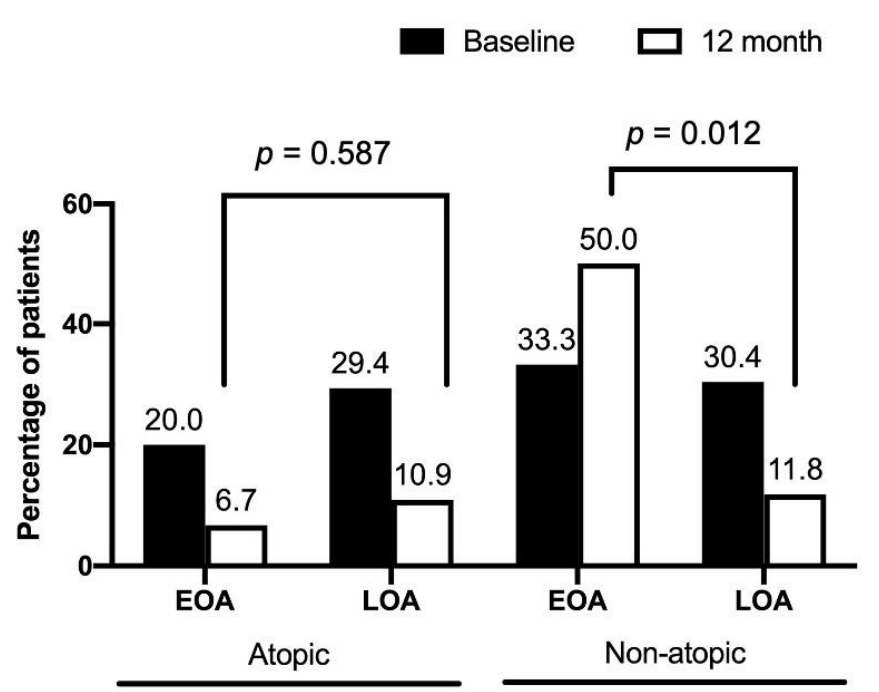
Figure 4. Percentage of acute exacerbations in early-onset asthma (EOA) and late-onset asthma (LOA) patients with atopic and nonatopic status after 12-month treatment. The baseline percentages of acute exacerbation were similar between EOA and LOA in patients with atopic and non-atopic status. To elucidate the impact of age on clinical outcomes of patients with EOA and LOA, patients were stratified as age < and ≥ 65 years old. Among patients <65 years old ( n =